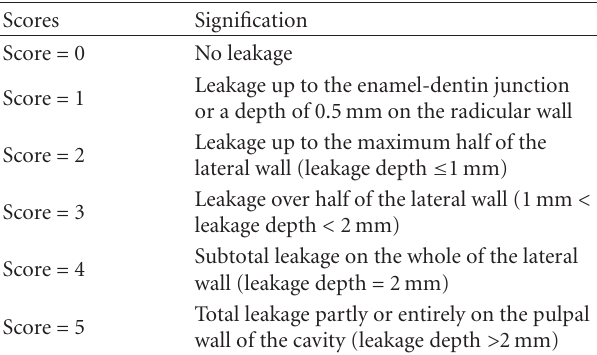
Table 2: The 6-point severity scale to evaluate the microleakage.